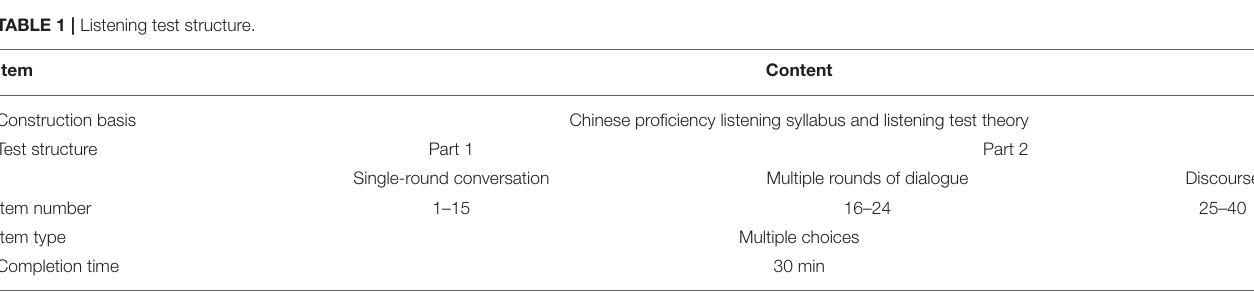
TABLE 1 | Listening test